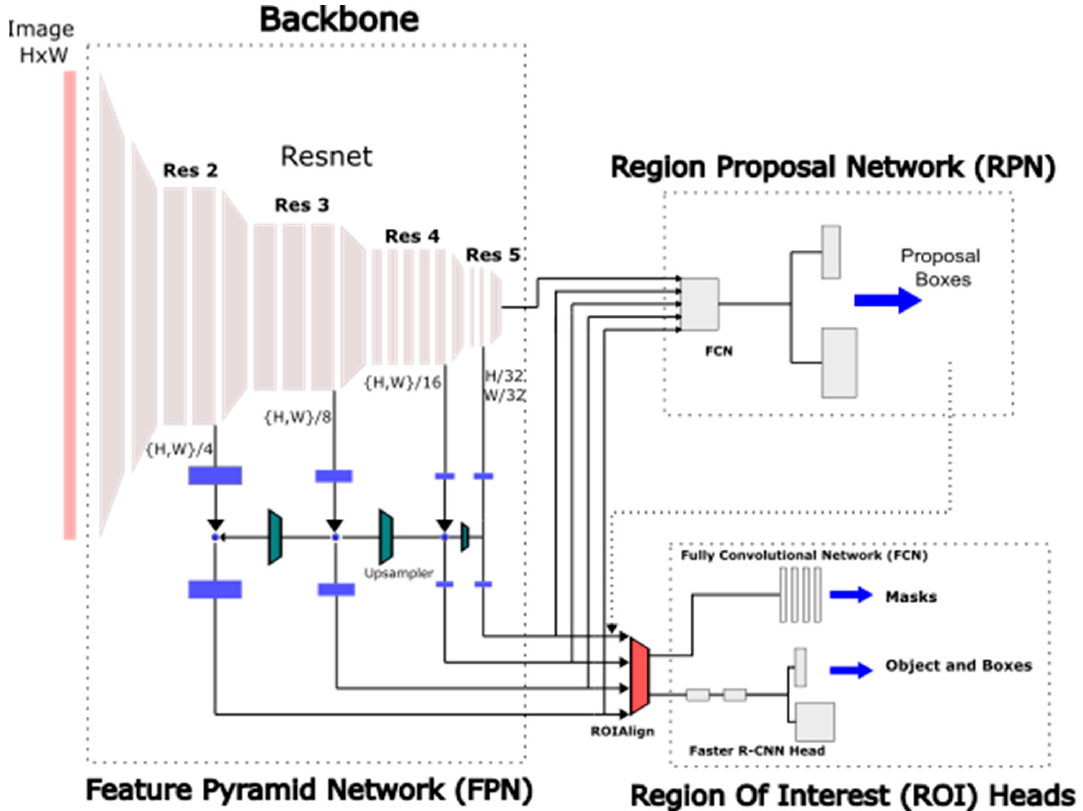
Figure 5. General Mask R-CNN architecture [30].